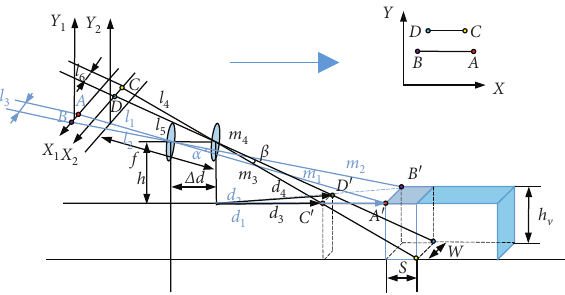
Figure 12: Schematic diagram of moving pseudo-obstacle after the ego-vehicle